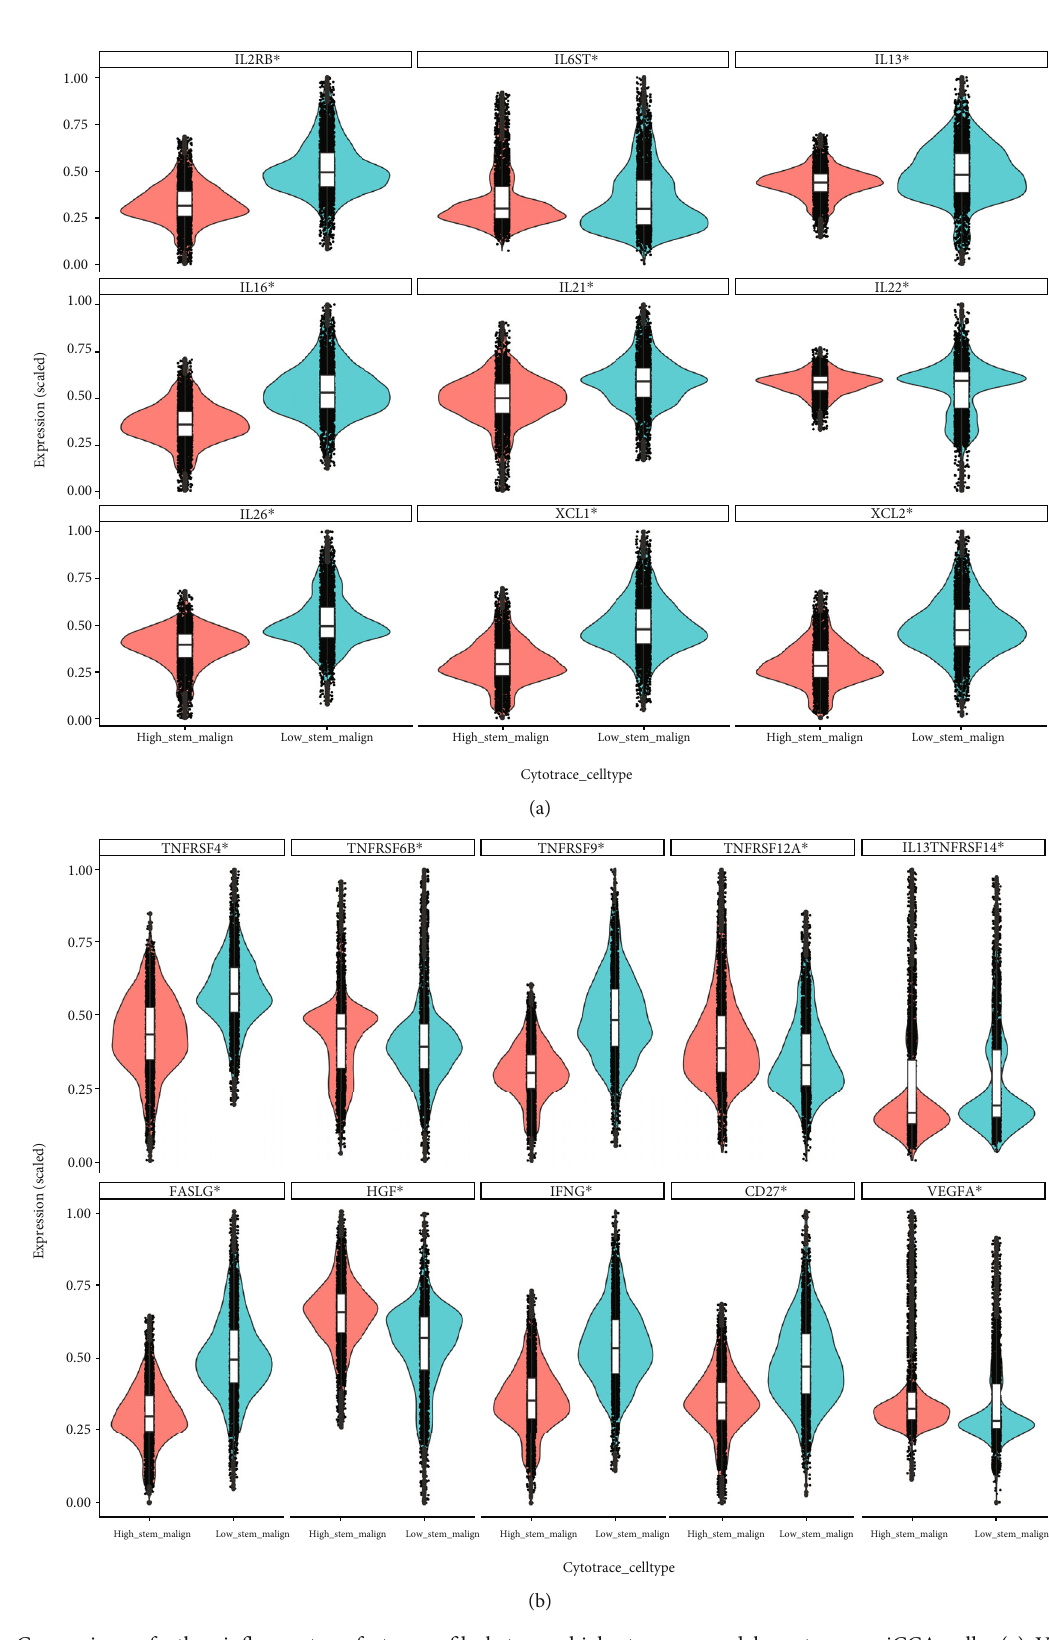
Figure 5: Comparison of other in fl ammatory factor pro fi le between high stemness and low stemness iCCA cells. (a) Violin plot of interleukin family. (b) Violin plot of TNF family and other in fl ammatory factors. ∗ indicates P < 0 : 05